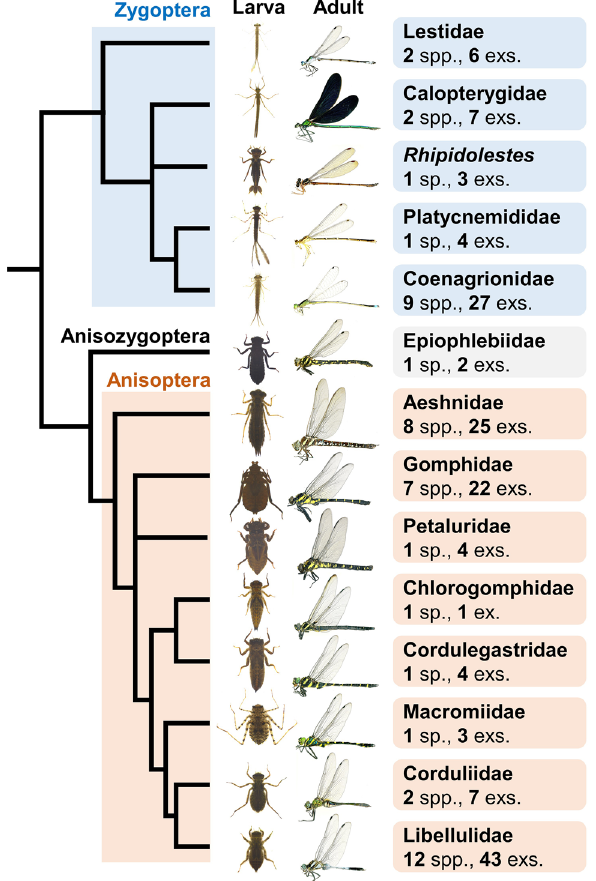
Figure 1. Summary of Odonata species examined in this study. 49 Odonata species (158 individuals) were photographed everyday (see Table 1 and Table S1 in detail). Phylogenetic tree of Odonata was modified from Bybee et al. 4 . The family status of Rhipidolestes is currently uncertain ( incertae sedis group 1 27 ). Larva and adult photos of the following 14 species are shown: Lestes sponsa (Lestidae), Calopteryx japonica (Calopterygidae), Rhipidolestes hiraoi ( incertae sedis ), Pseudocopera annulata (Platycnemididae), Ischnura asiatica (Coenagrionidae), Epiophlebia superstes (Epiophlebiidae), Aeshna crenata (Aeshnidae), Sieboldius albardae (Gomphidae), Tanypteryx pryeri (Petaluridae), Chlorogomphus brunneus (Chlorogomphidae), Anotogaster sieboldii (Cordulegastridae), Macromia daimoji (Macromiidae), Somatochlora uchidai (Corduliidae), and Orthetrum albistylum